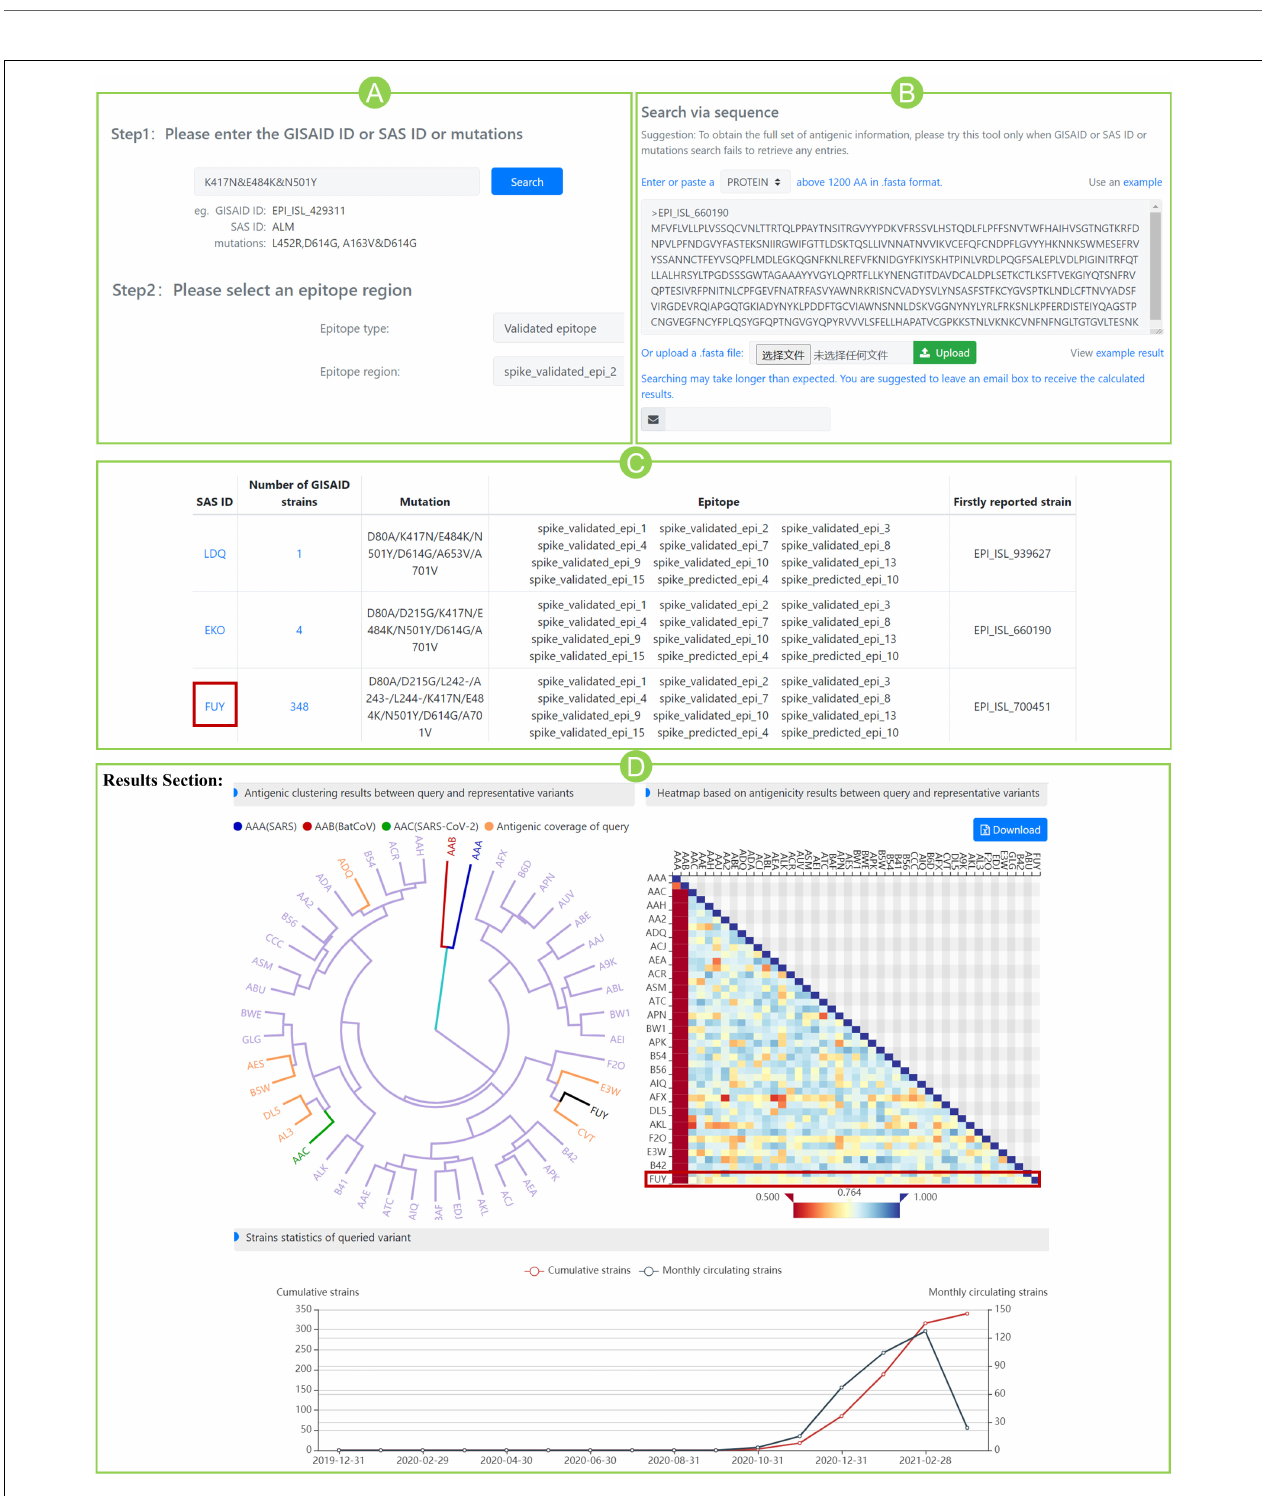
FIGURE 2 | Case study for community circulating strain B.1.351 from South Africa. (A) Submit mutations K417N&E484K&N501Y and specify a pre-defined epitope region. (B) Alternatively, submit the spike sequence in “predict” section. (C) Variants that contain the queried mutations. For each variant, the number of GISAID strain, mutation information, epitope regions involving queried mutations, and the firstly reported strain were listed in the table. (D) Results section of variant “FUY”. The antigenicity clustering tree (left) shows the potential sensitivity (in yellow) or resistance (in purple) of queried variant to all representative variants. The three benchmark variants are marked red (AAA), blue (AAB), and green (AAC), respectively. The heatmap (right) shows the antigenic scores between query and representative variants (marked in red box). The line chart (bottom) indicates the dynamic circulation statistics of queried variant. The blue line shows the number of monthly detected circulating strains and the red line shows the cumulative